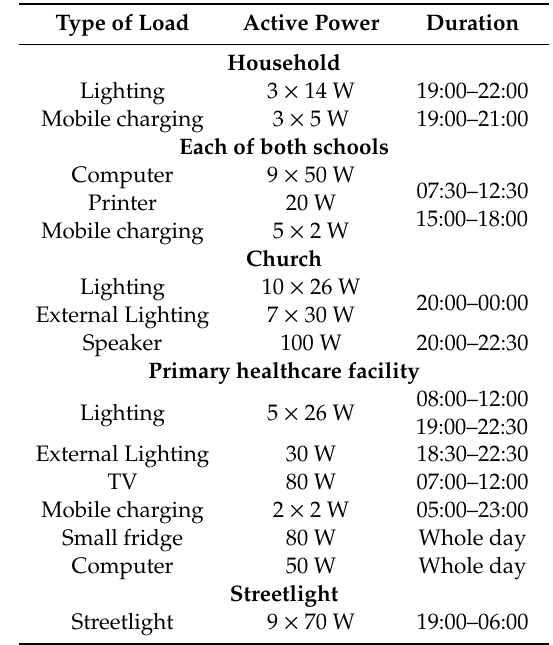
Table 1. Daily electricity demand in the “Tacuaral de Mattos”